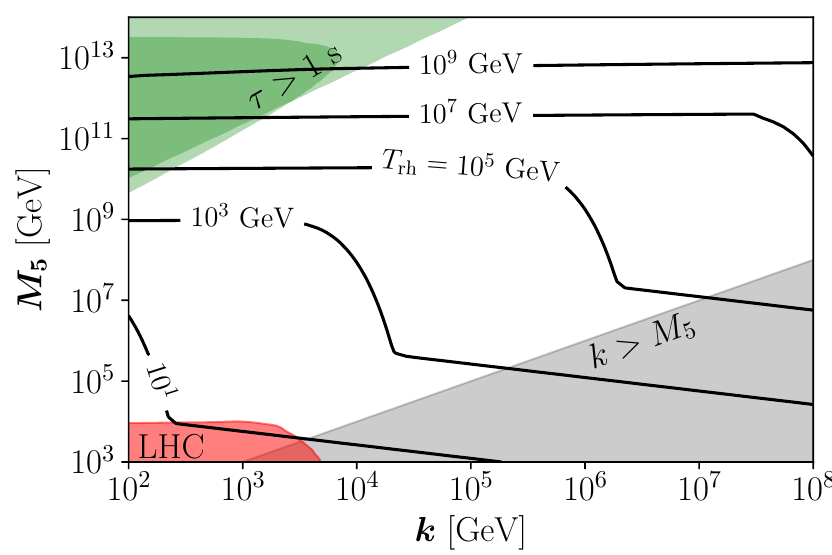
Figure 2 . Direct freeze-in: contours for the reheating temperature T rh required to reproduce the observed DM abundance, for m DM = 1 MeV. The red-shaded region is in tension with LHC results from refs. [4, 62]. The gray-shaded region for which k > M 5 is beyond the EFT approach. The green-shaded region corresponds to lifetimes of the radion and the lightest KK-mode longer than 1 s. corner corresponding to k > M is beyond our EFT approach. The red-shaded region 5 in the lower-left corner represents the present non-resonant LHC Run-II bounds. The re- sults from non-resonant searches, in contrast with the resonant searches (see, for example, refs. [64, 65]), are not easy to translate into a bound in the ( M , k ) plane. In the 5